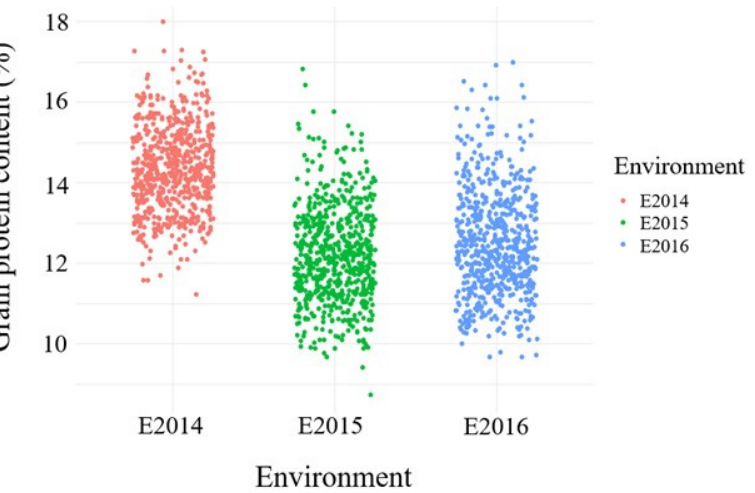
Figure 1. Variation of grain protein content for all the NAM 650 across the three environments. The X-axis depicts the three environments, namely 2014, 2015, and 2016; the Y-axis shows the GPC as a percentage.